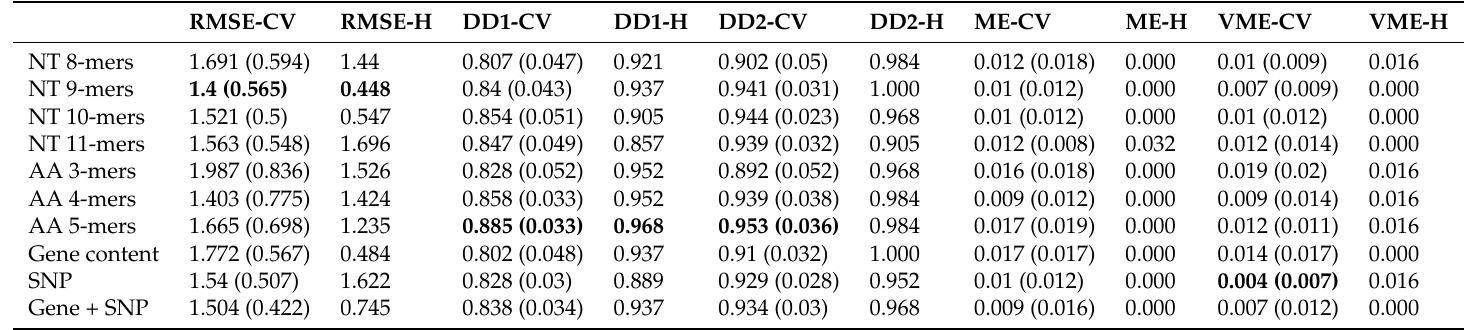
Table A30. N. gonorrhoeae